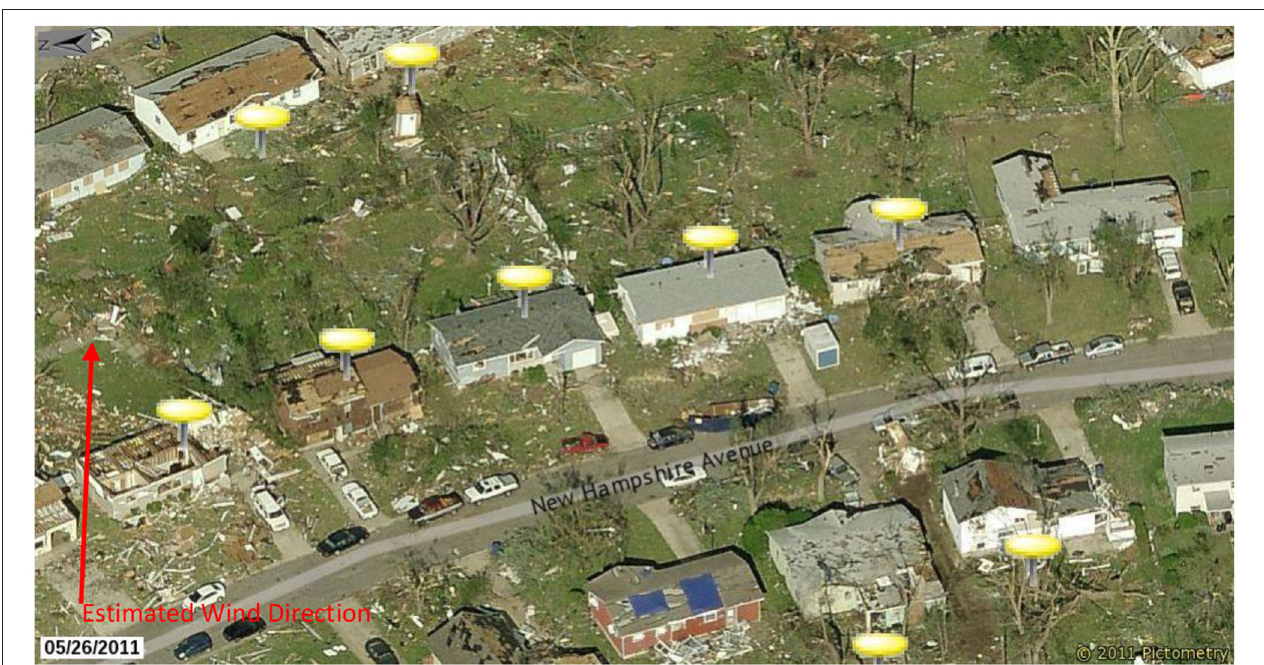
FIGURE 10 | Joplin, MO Tornado Damage at Windspeeds between 90 and 109 mph. Image resolution and quality reduced for publication. Image courtesy of Eagleview Technologies, Inc.